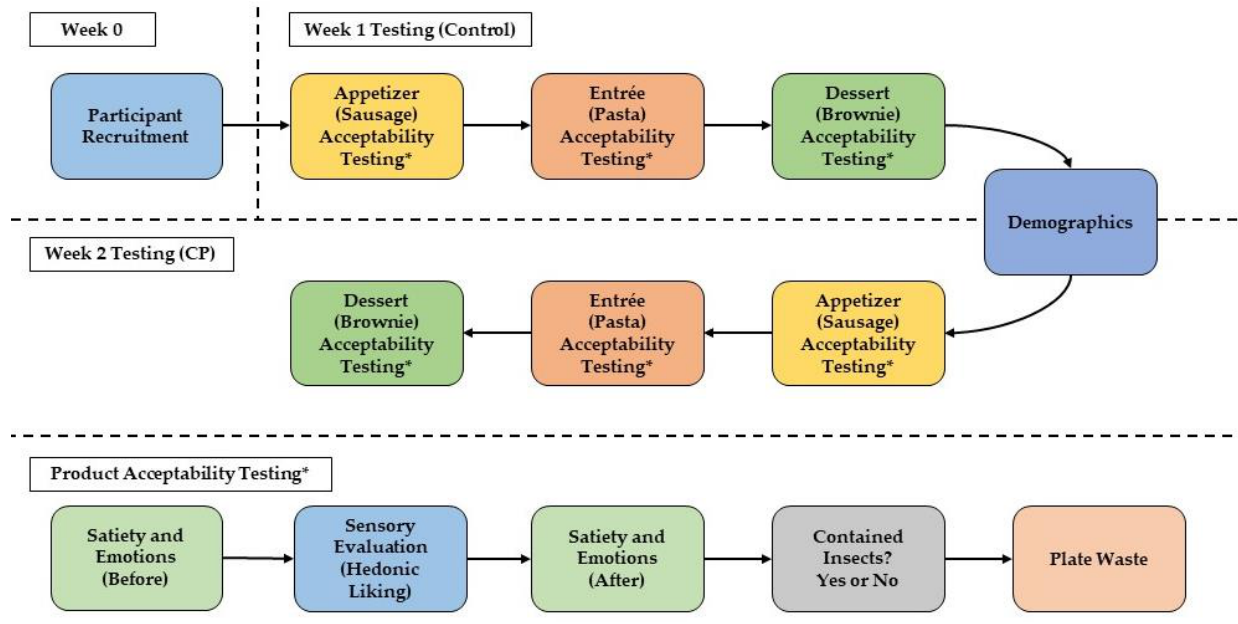
Figure 1. Flow diagram of the sensory test conducted. The Product Acceptability Testing flow diagram describes the factors measured during each product evaluation. * For week 1 and week 2 of acceptability testing for all products evaluated, subjects answered four questionnaires, subjective satiety and emotions before and after consumption, hedonic questionnaire, and answered whether or not the product contained insects. Upon completion of testing, all products were weighed to determine plate waste.